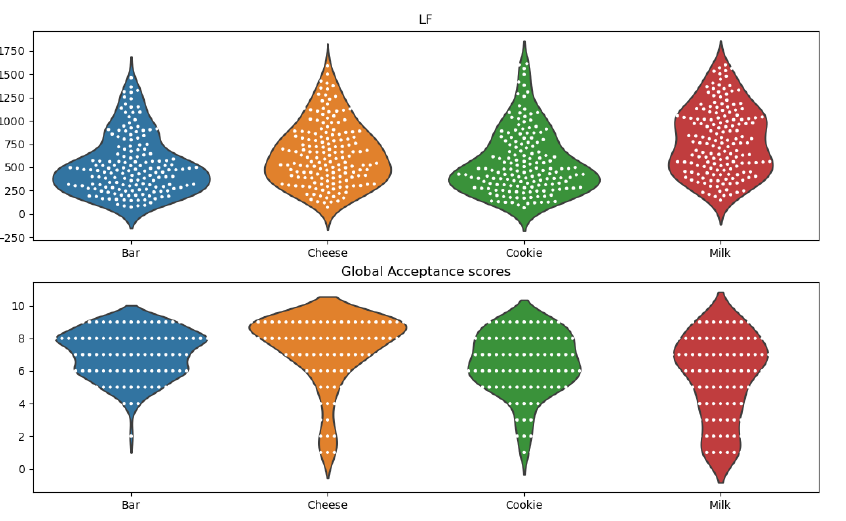
Figure 8. Violin plots representing the distributions of the HRV LF feature values and global acceptance scores for each product across 162 experiments (experiments with outlier values of LF were removed). On top : Distribution of LF values obtained in the first 2.5 min of contact with each product. Bottom : Distribution of the scores obtained in the global acceptance